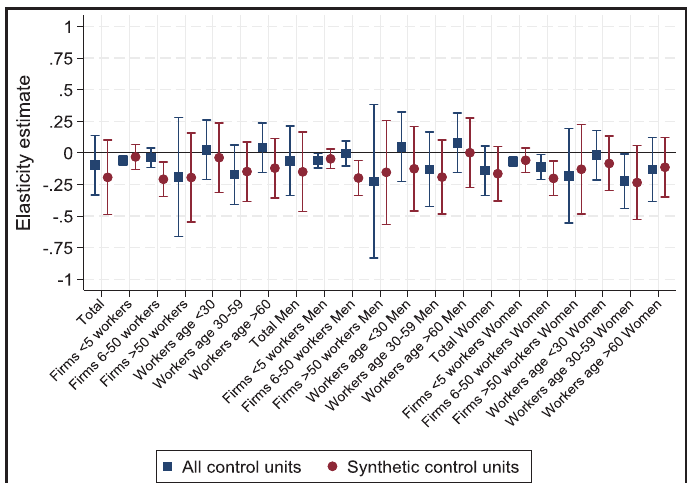
Instrumental variable results,